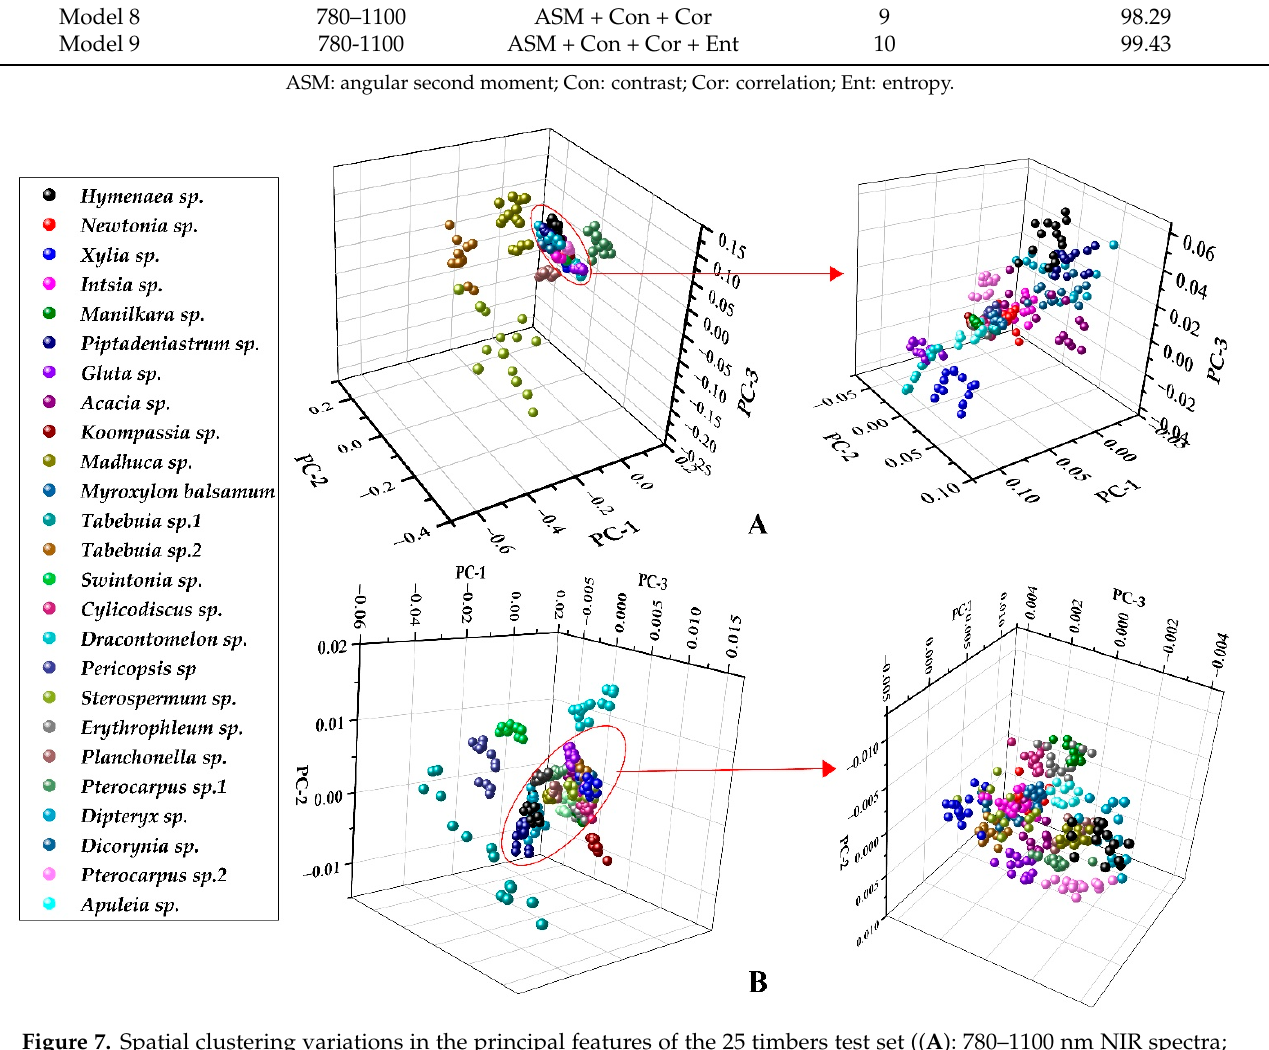
Figure 7. Spatial clustering variations in the principal features of the 25 timbers test set (( A ): 780–1100 nm NIR spectra; ( B ): 780–1100 nm NIR spectra combined with the four GLCM features).